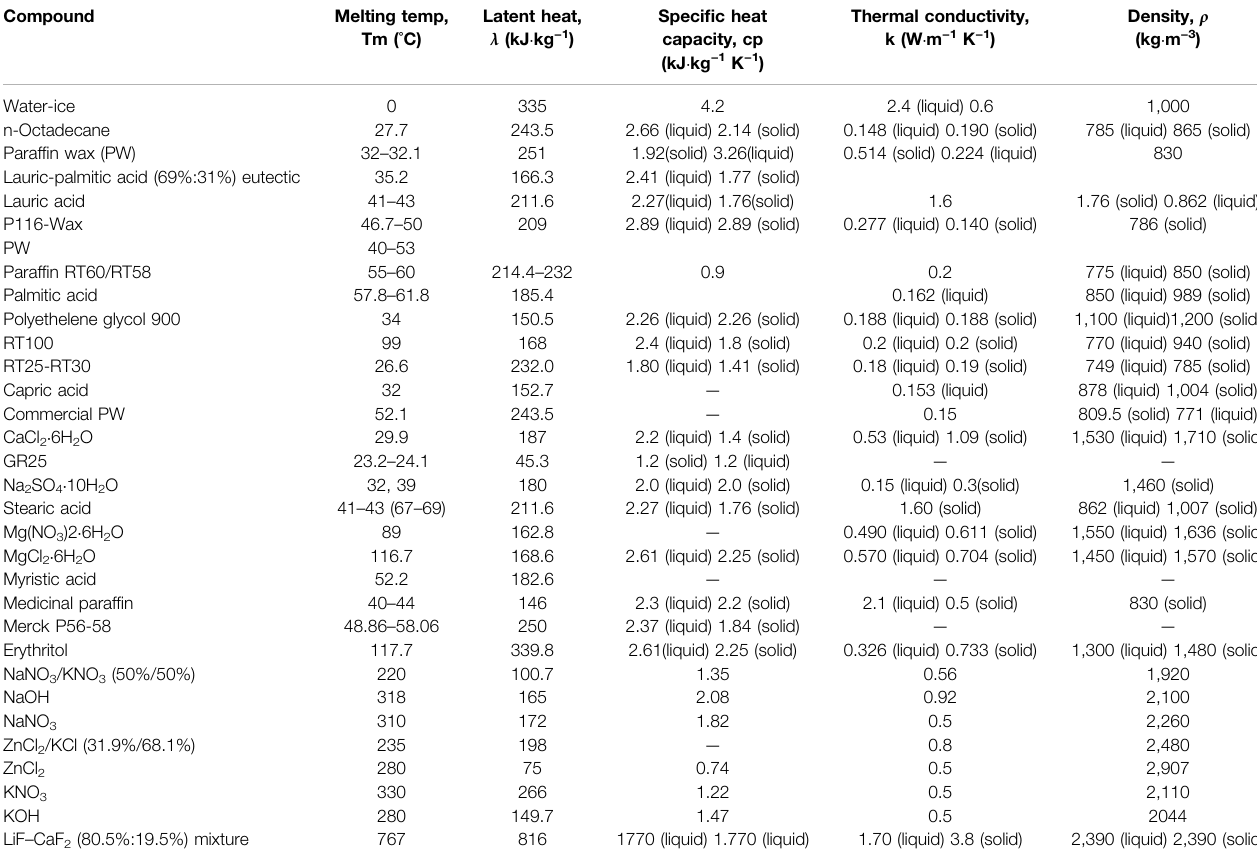
TABLE 2 | Thermo-physical properties of solid-liquid PCMs. Compound